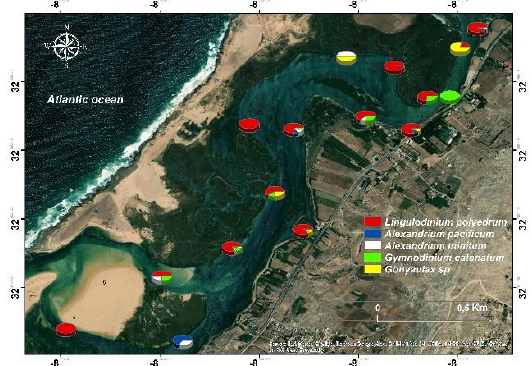
Figure 5. Spatial distribution (21 stations) of dinoflagellate cysts (cysts g−1 dry sediment) in sediments of Sidi Moussa Lagoon